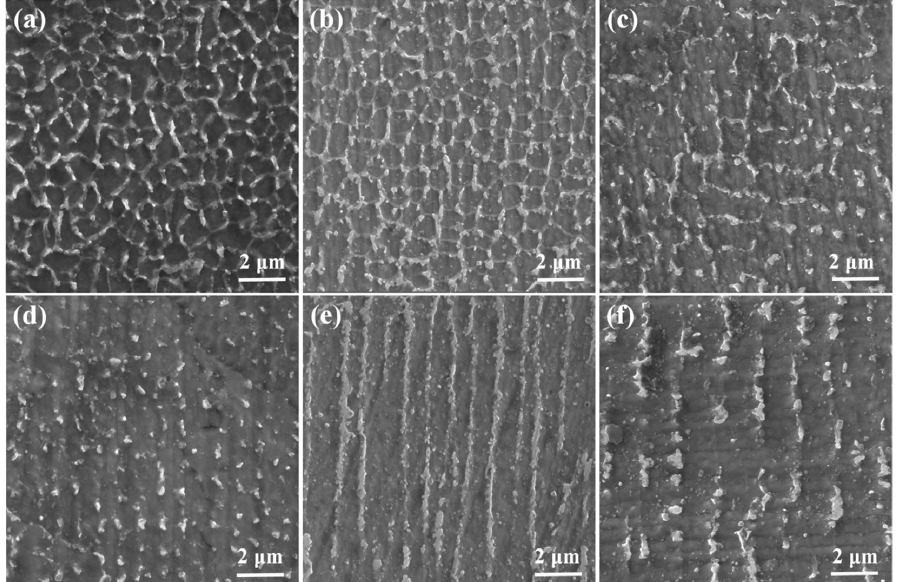
Figure 8. High-magnification SEM graphs of cellular dendrites and columnar dendrites in the X–Z plane of SLMed IN718 samples with different laser volume energy densities; ( a , d ) 85.86 J/mm 3 , ( b , e ) 100 J/mm 3 , and ( c , f ) 117.17 J/mm 3 .